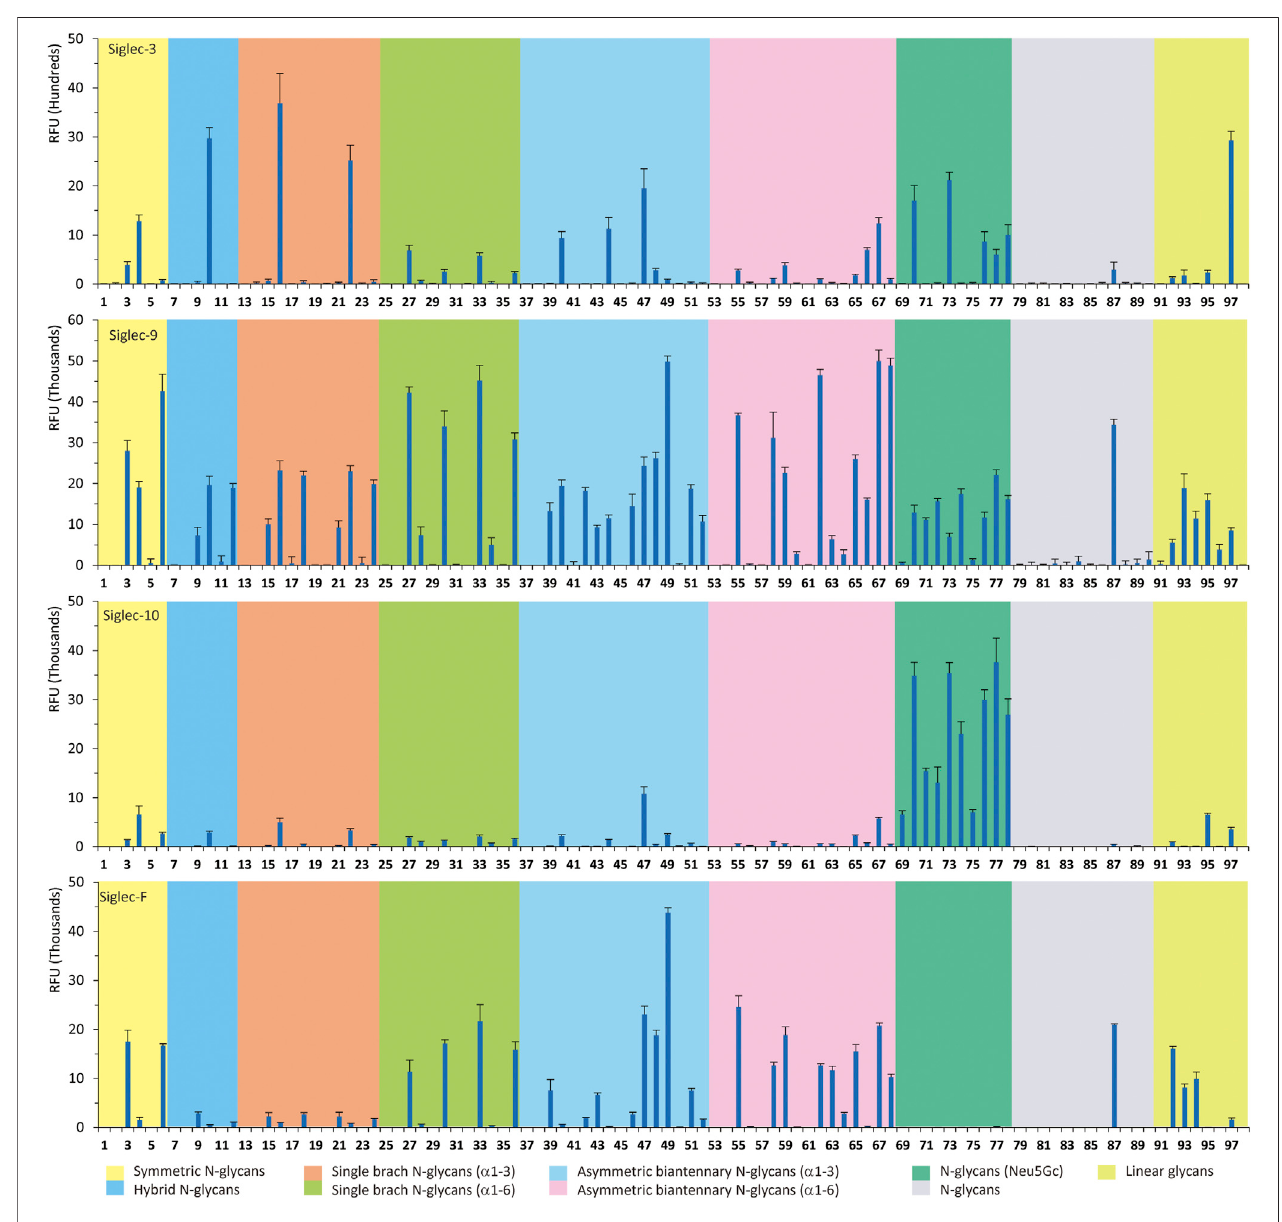
FIGURE 1 | Selective recognition of Sia-containing N -glycans by human and mouse Siglecs.